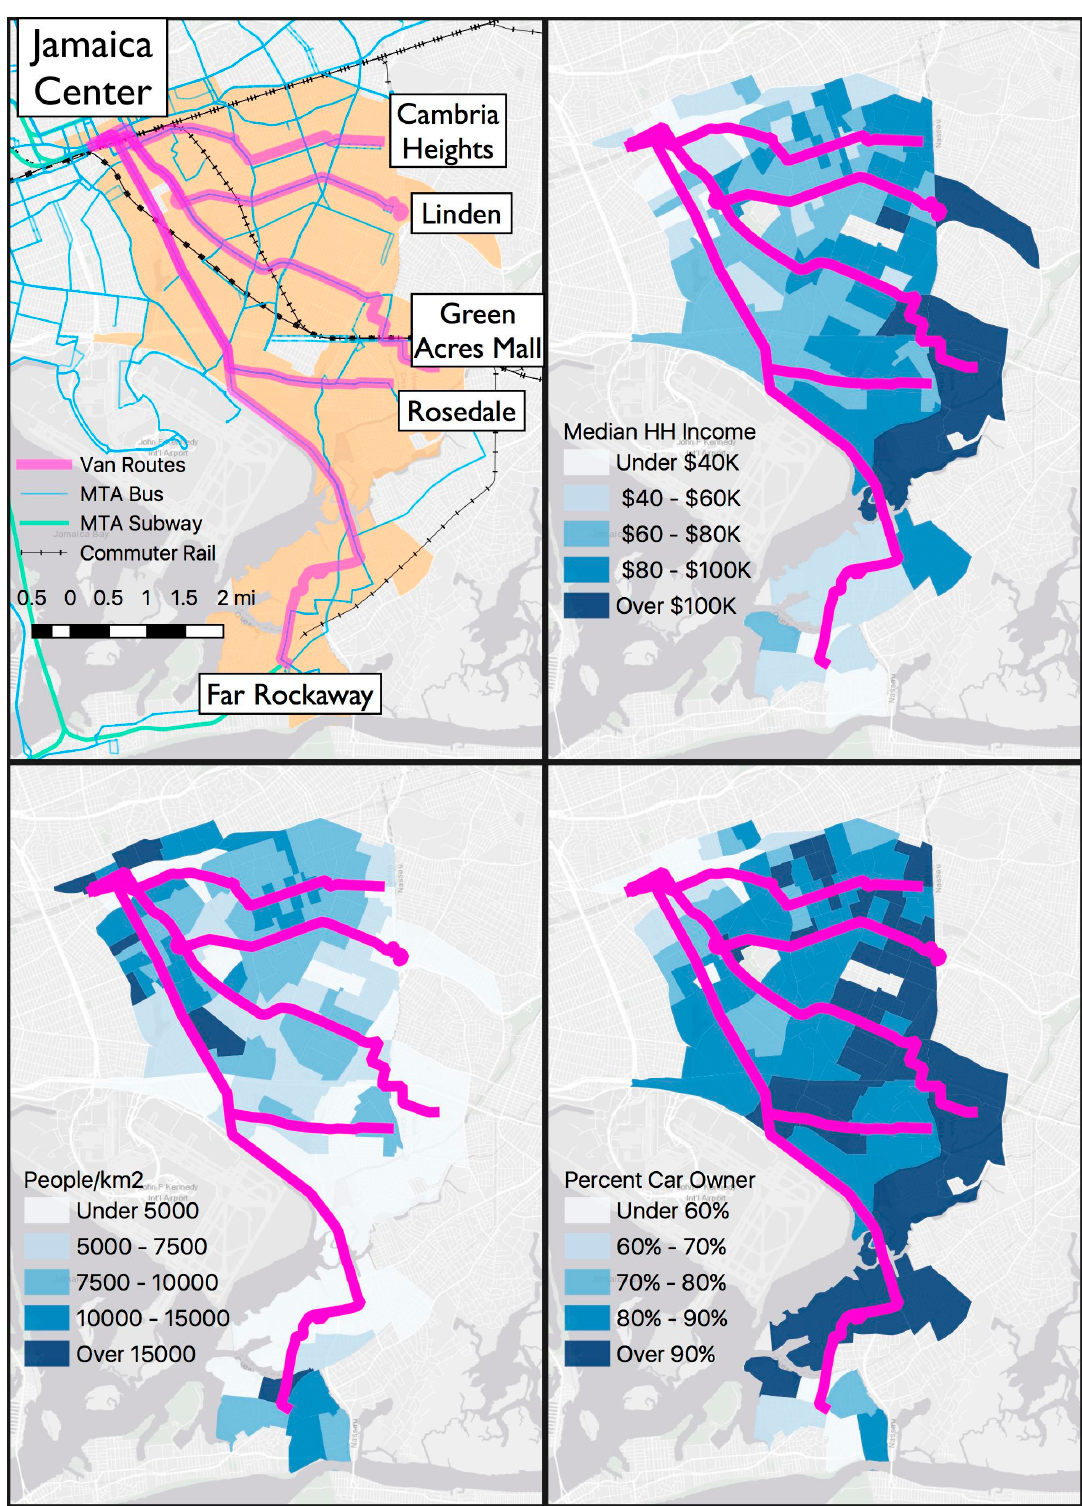
Figure 2. Clockwise from top left: commuter van routes and MTA transit, household income, car ownership, and population density [22].